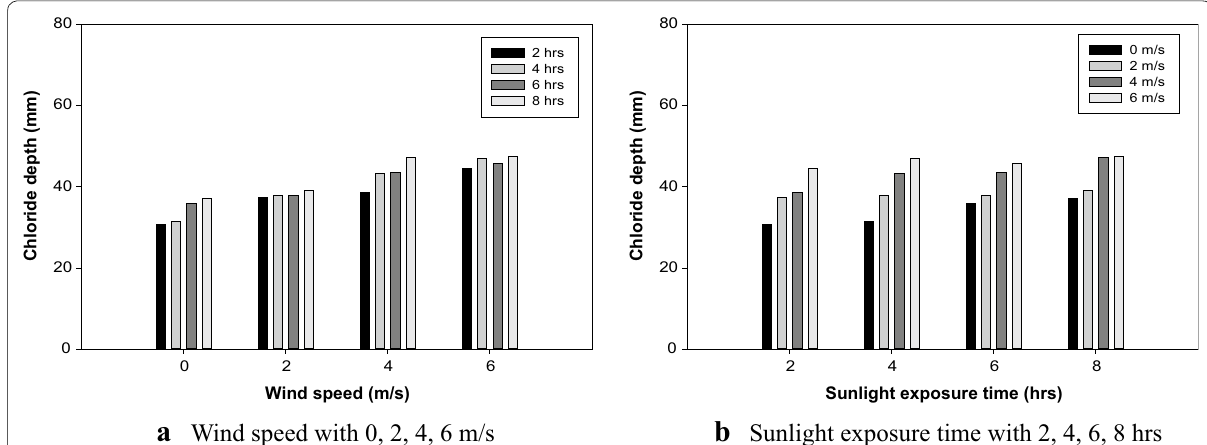
Fig. 5 Evaluation of chloride diffusion depth rate: a wind speed with 0, 2, 4, 6 m/s, b sunlight exposure time with 2, 4, 6, 8 h.